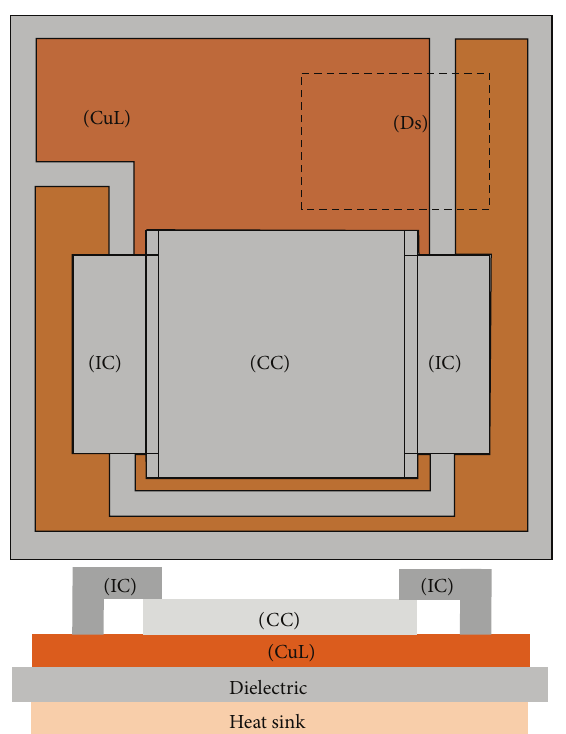
Figure 3: Front view and cross section of the single-cell receiver developed in COMSOL.